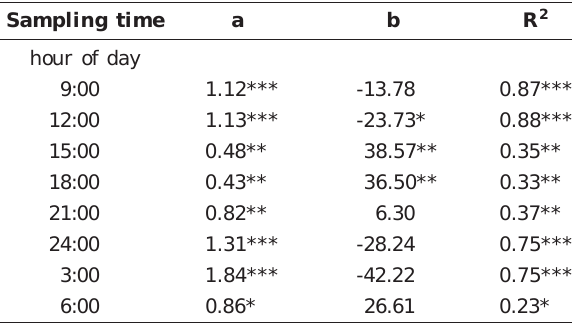
Table 1. Relation between mean daily and mean hourly N 2 O emission rates